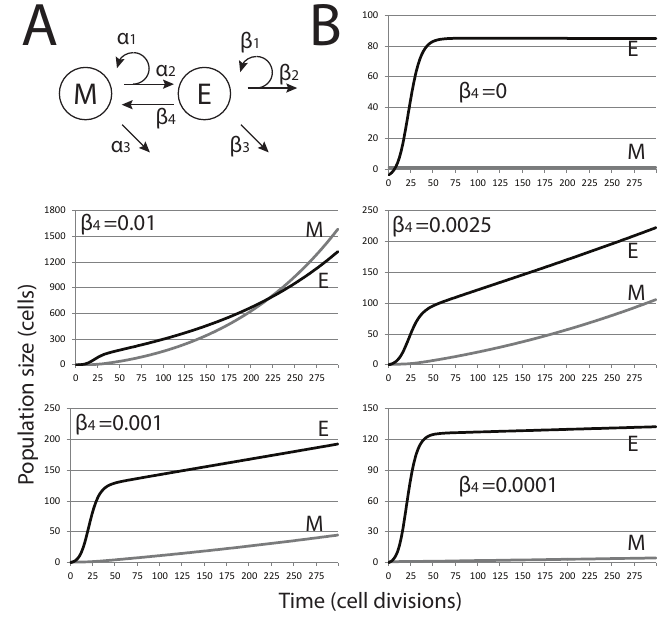
Figure 2. Effect of EMT on the size of metastatic tumors. ( A ) Modified model diagram, including EMT; ( B ) each plot shows the trajectories of M and E for different values of β (rate of EMT). As β is increased, the dynamics change from close-to-equilibrium to 4 4 exponential growth, where eventually, the size of M will overtake E